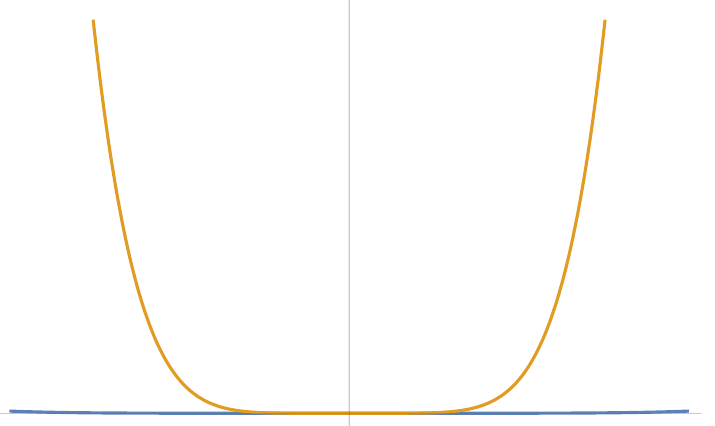
Figure 2 . Schematic picture of the effective potential in the case of g 4 (cid:29) 1 . We take y = 1 for simplicity. The yellow and blue lines shows G = 1 . 0 × 10 2 , G = 1 . 0 × 10 3